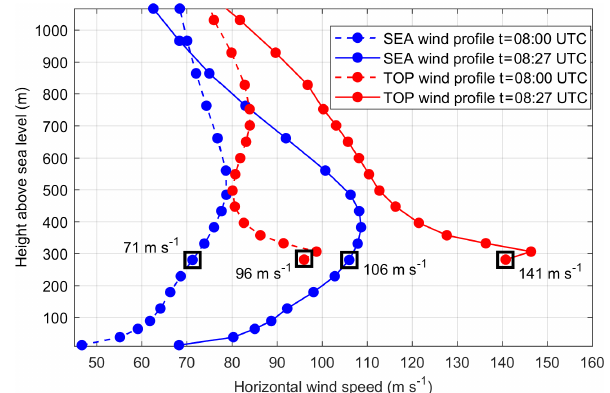
Figure 10. Vertical profile of the REAL030 instantaneous horizon- tal wind speed (ms − 1 ) at 08:00UTC and at the peak gust time 08:27UTC: comparison between the upstream winds over the sea (SEA) and the orographic winds over the mountain top (TOP).